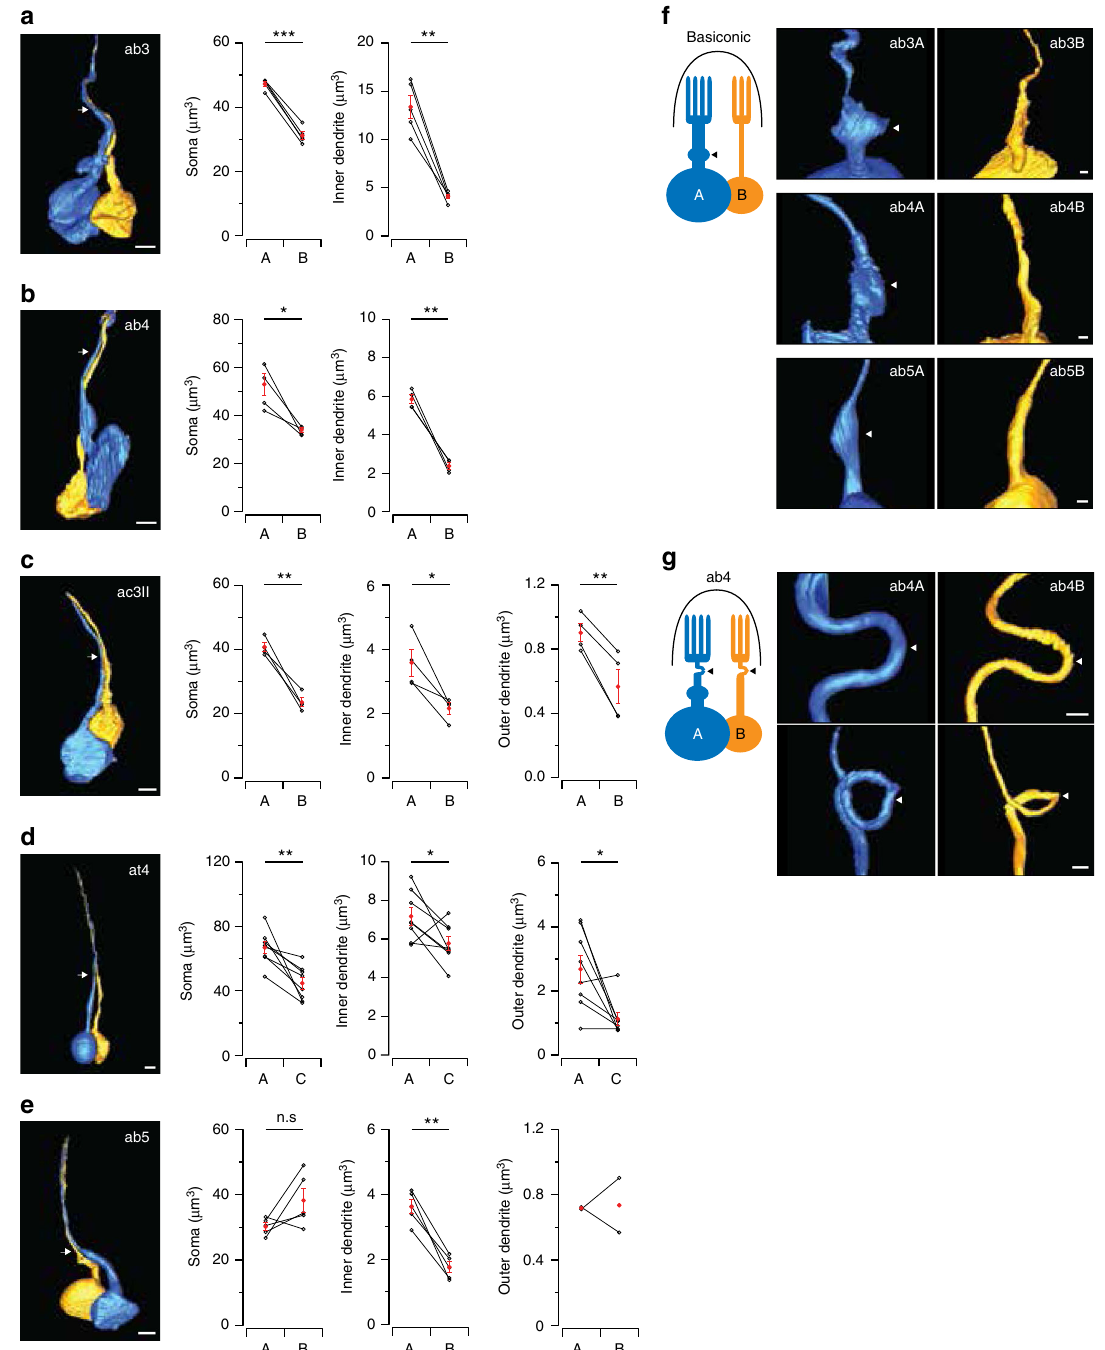
Fig. 6 Systematic morphometric analysis of grouped ORNs. a – e Volumes of the soma, inner and outer dendrites of the paired ORNs in fi ve sensillum types. (Left) Sample 3D reconstruction based on SBEM images. Arrows indicate the cilium base, a constricted region separating the inner and outer dendrites. Due to technical limitations, the outer dendrites of most basiconic sensilla could not be completely reconstructed (see Methods for details). Scale bars: 2 µ m. Lines connect measurements from paired ORNs, mean ± s.e.m. n = 4 – 5 for all except for at4, n = 8. * P < 0.05, ** P < 0.01, *** P < 0.001, paired t test. The P values are a 0.00004 and 0.001; b 0.033 and 0.003; c 0.0004, 0.035, and 0.008; d 0.004, 0.041, and 0.017; e 0.125 and 0.001. Error bars and statistics are unavailable for the ab5 outer dendrites as only two data points were obtained. f , g Novel morphological features. f An enlargement of the inner dendrite (arrow head) was observed in the “ A ” ORNs in all three characterized basiconic sensilla. g A bend or loop (arrow head) was observed in the unbranched outer dendrite of the ab4 ORNs. Scale bar: 500 nm. Source data are provided as a Source Data fi le. ORN olfactory receptor neuron, SBEM serial block-face scanning electron